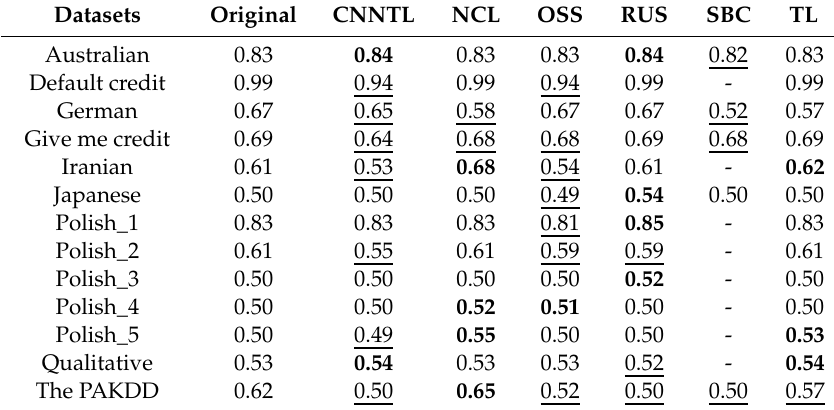
Table 16. AUC for NAC classifier after undersampling algorithms.